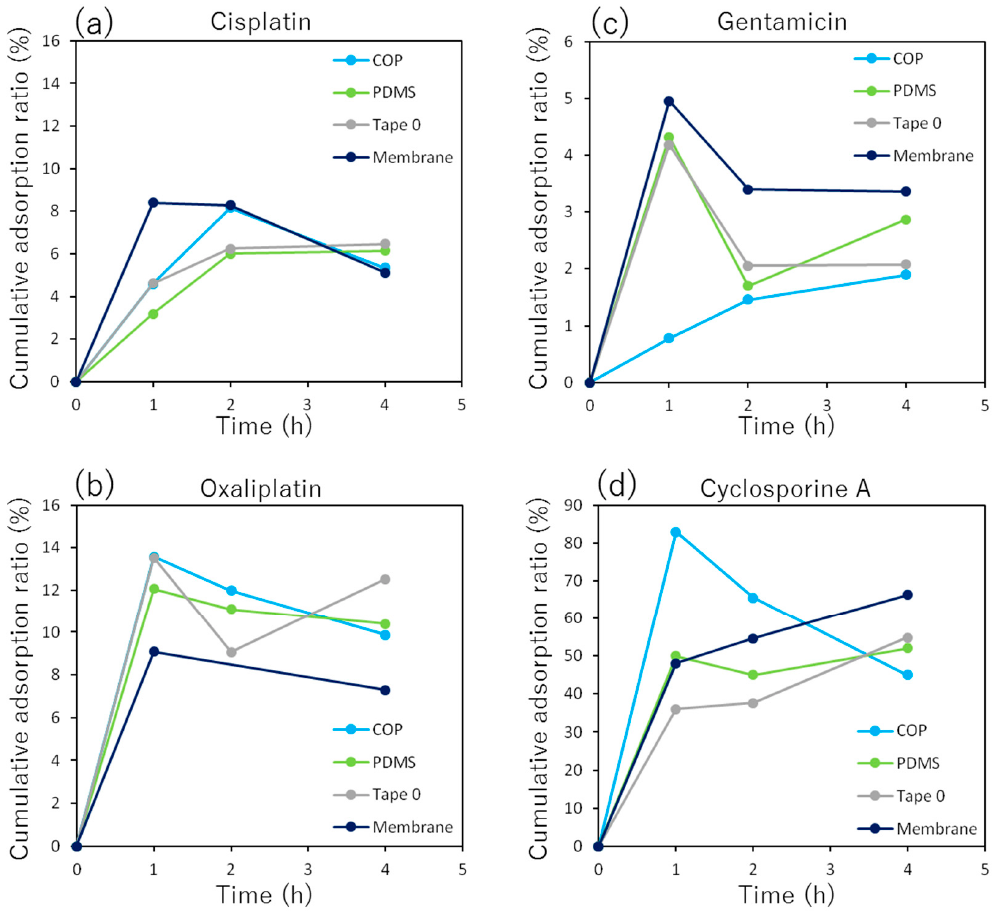
Figure 2. Time course of each nephrotoxic drug adsorption onto each material used in MPS. ( a ) Cisplatin; ( b ) Oxaliplatin; ( c ) Gentamicin; ( d ) Cyclosporine A.